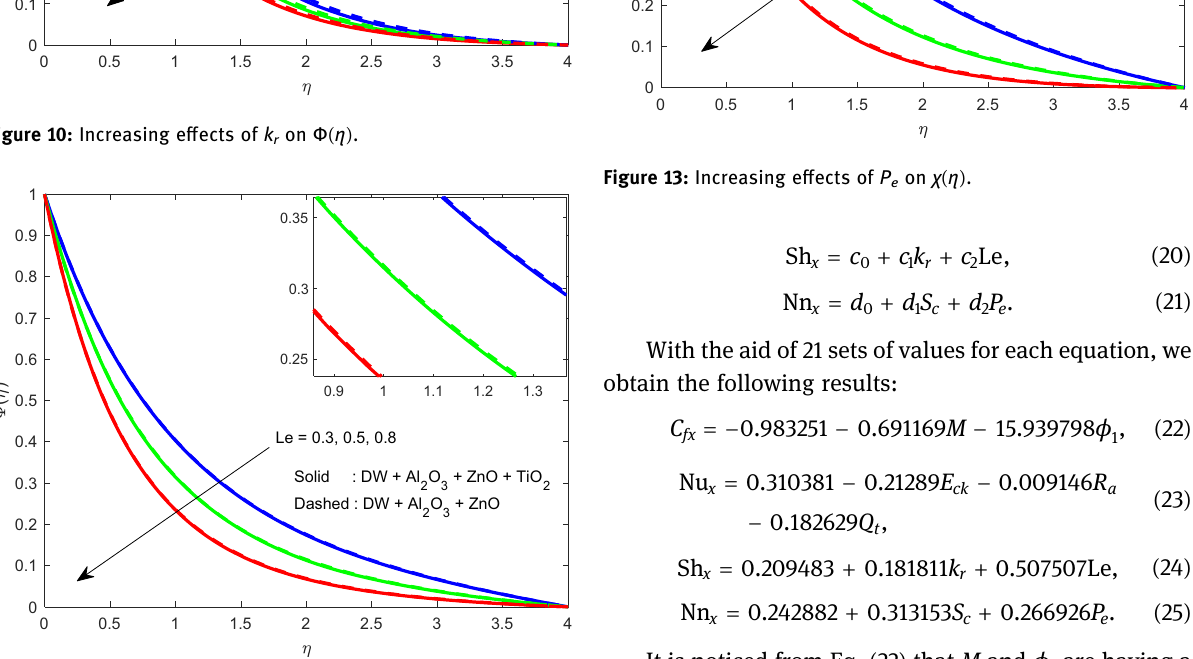
Figure 11: Increasing e ff ects of Le on Φ ( η ) .